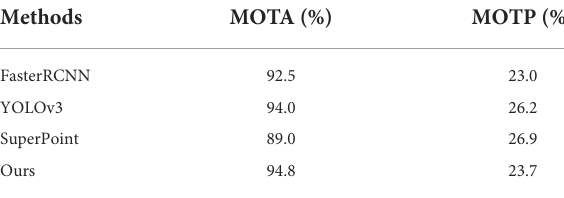
TABLE 2 Comparison of sperm target tracking